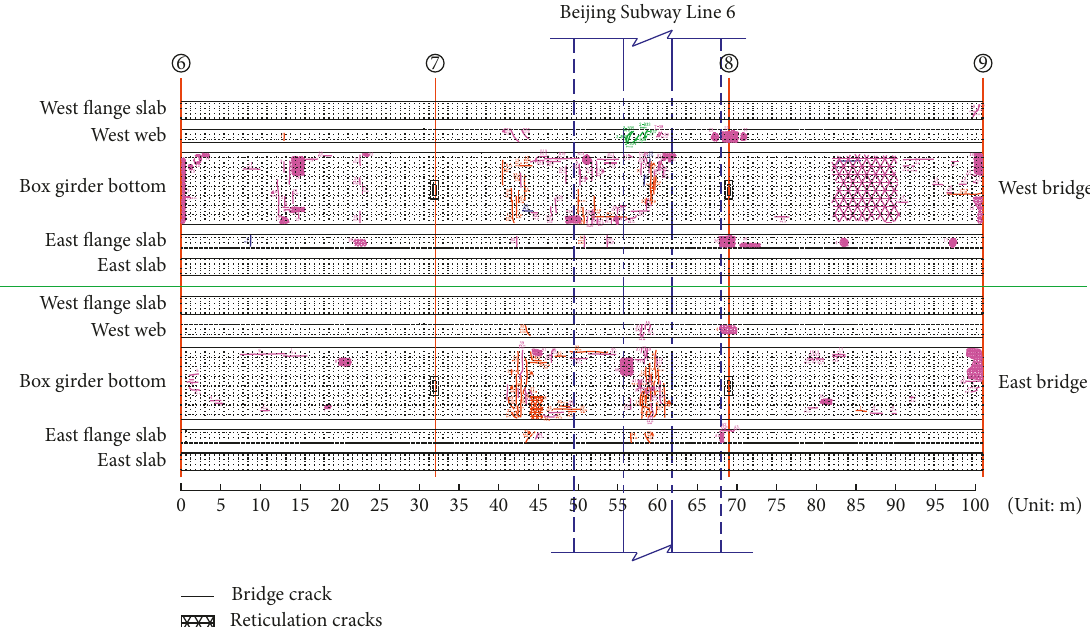
Figure 14: Distribution diagram of cracks.